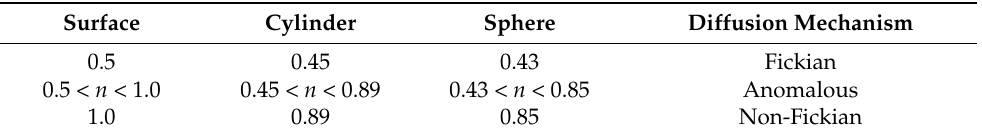
Table 1. Interpretation of the release mechanisms from polymeric systems, as proposed by Korsmeyer– Peppas et al.